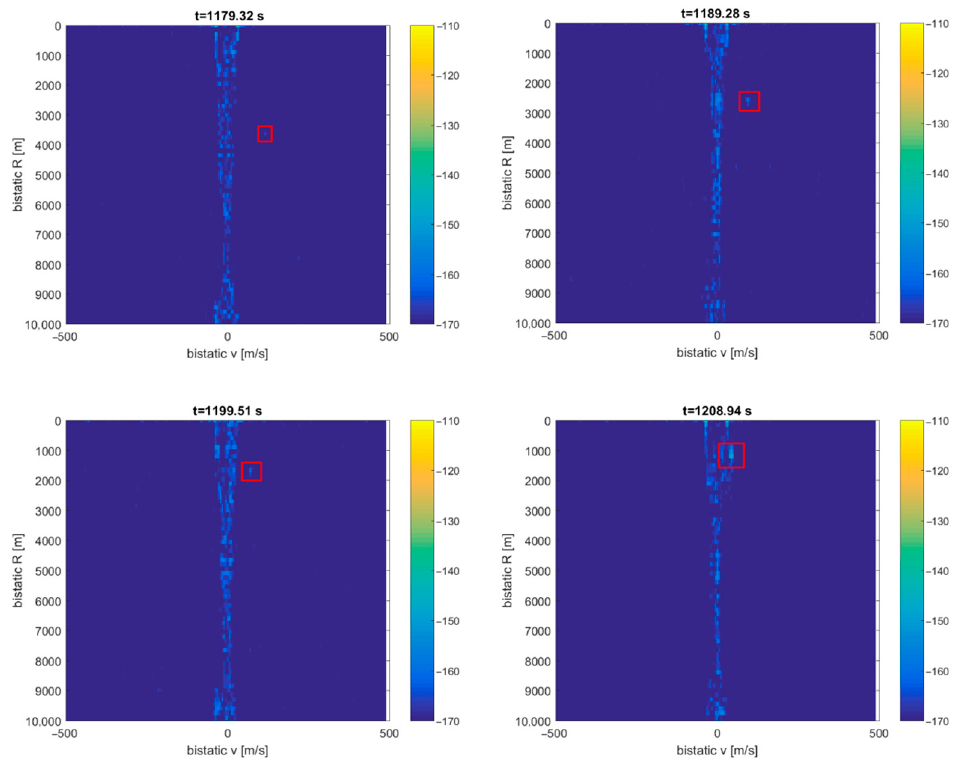
Figure 17. Detection results of the CASA C-295 aircraft (subsequent time stamps, scene in Figure 16).